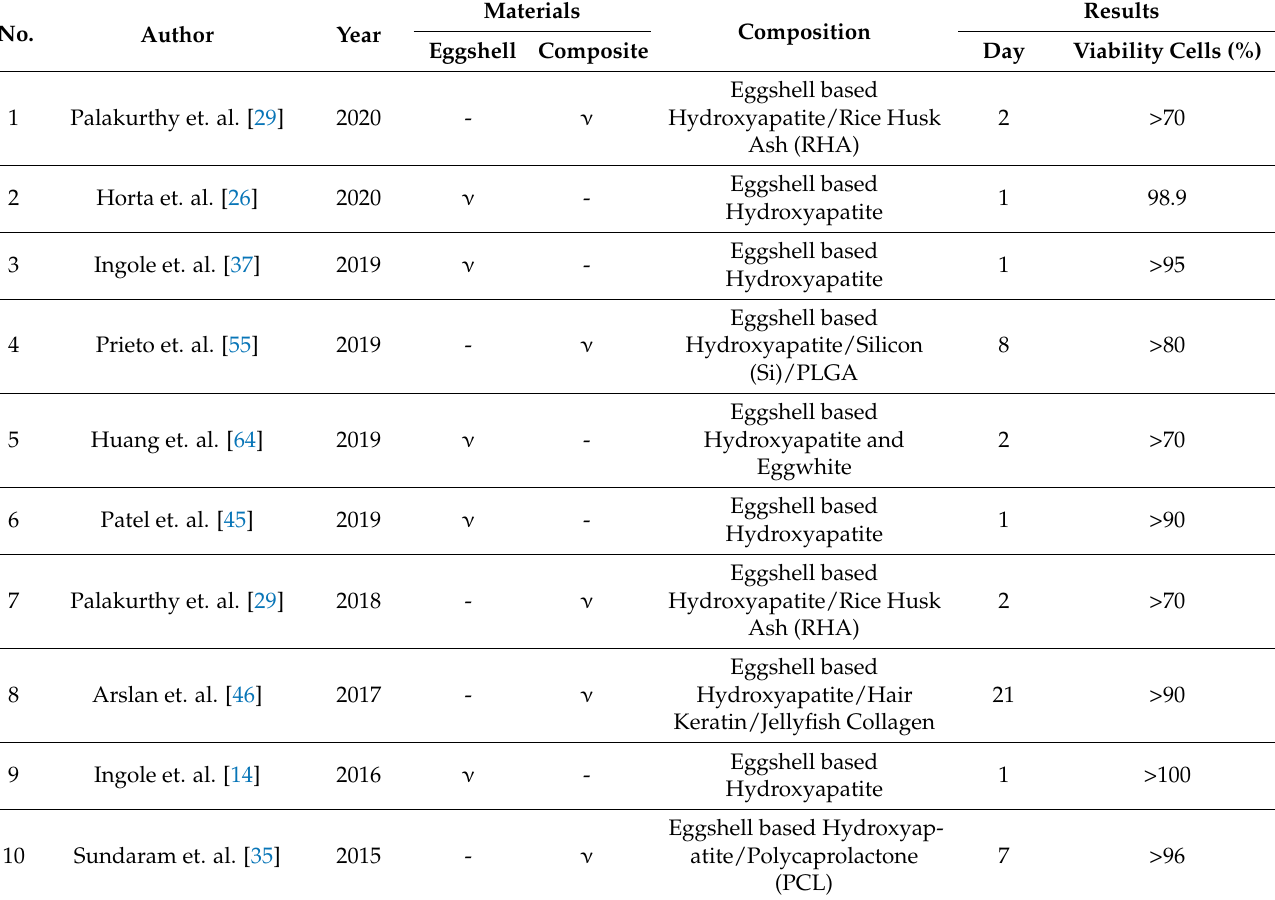
Table 3. Results for viable cell of cytotoxicity testing using human stem